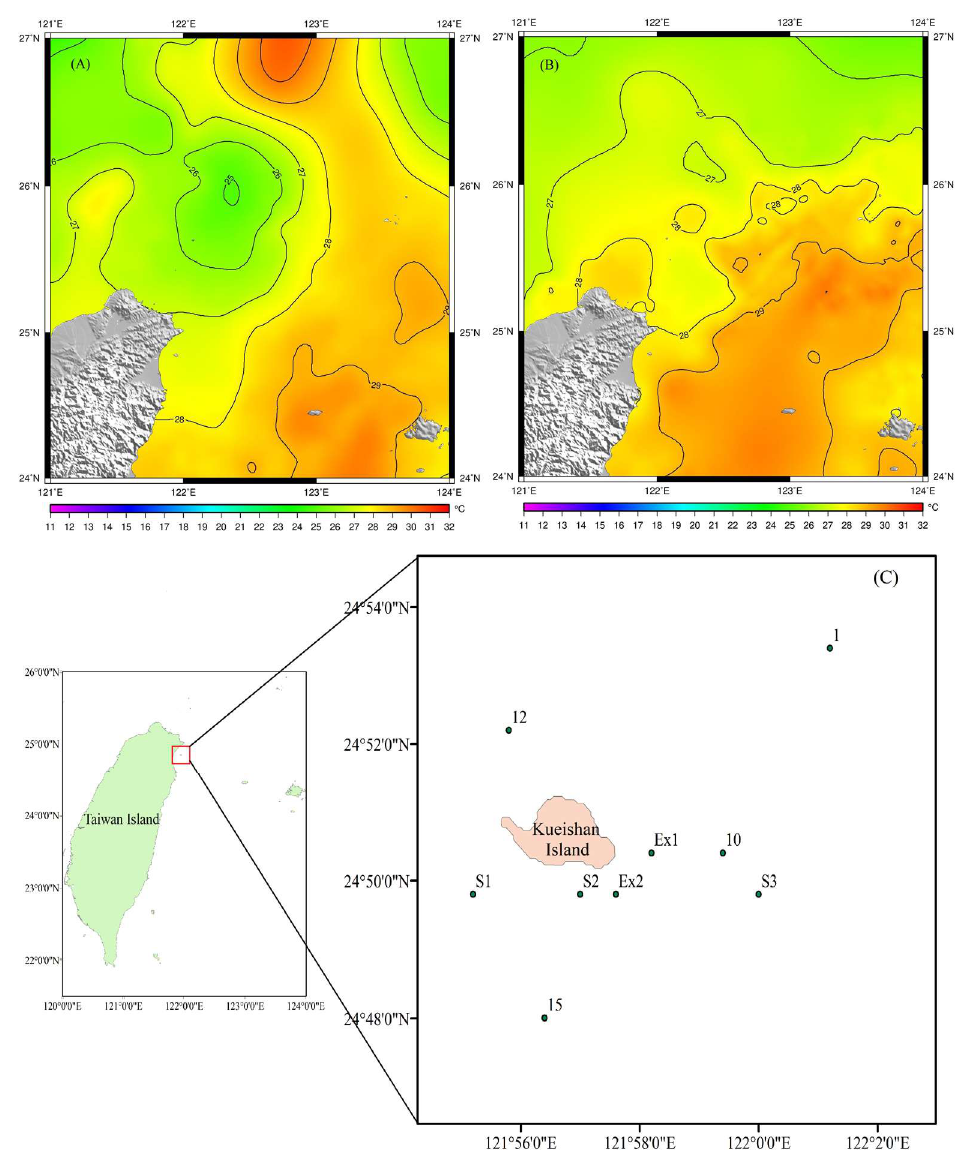
Figure 1. Satellite images of the sea surface temperature on 1 June 2018 ( A ) and 21 June 2019 ( B ), and the maps of the research area and sampling stations ( C ).